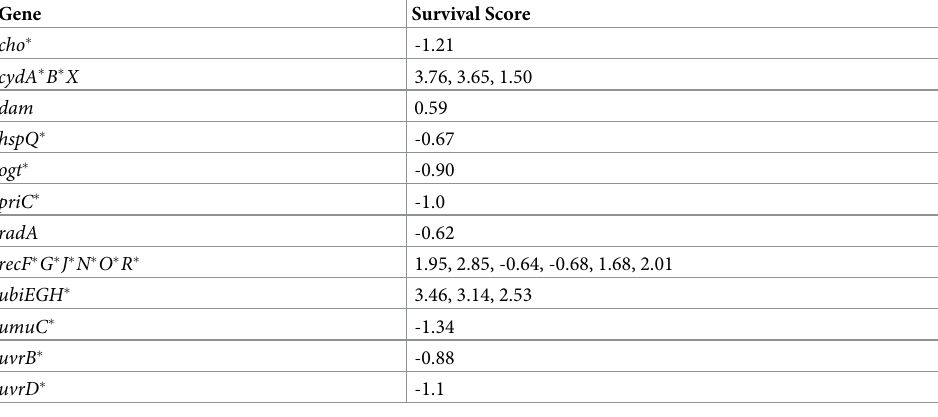
Table 1. Genes with significant effects from survival profiling candidate lists that fall into the previously known pathways of DNA replication/repair and